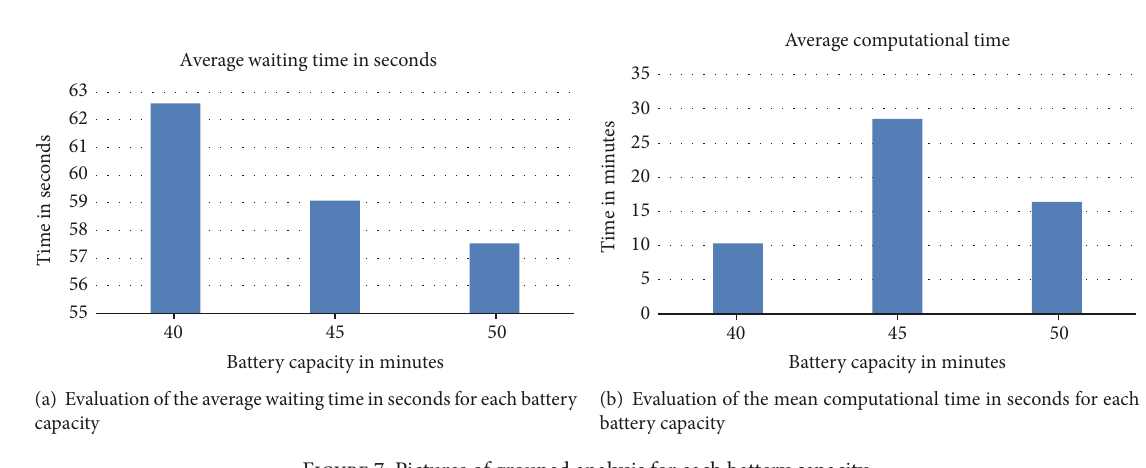
Figure 6: Pictures of grouped analysis for each Network.